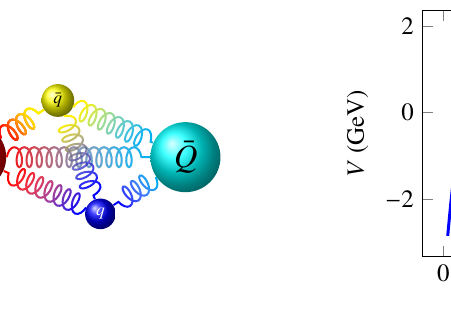
near the expected mass of χ c 1 (2 p ): the X (3940) peak in D ¯ D ∗ , observed by Belle in 2007